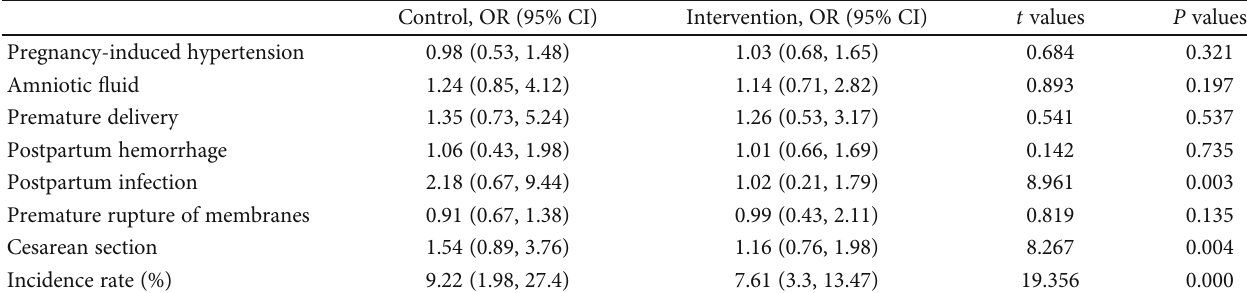
Table 10: Comparison of perinatal complications between the two groups, cases